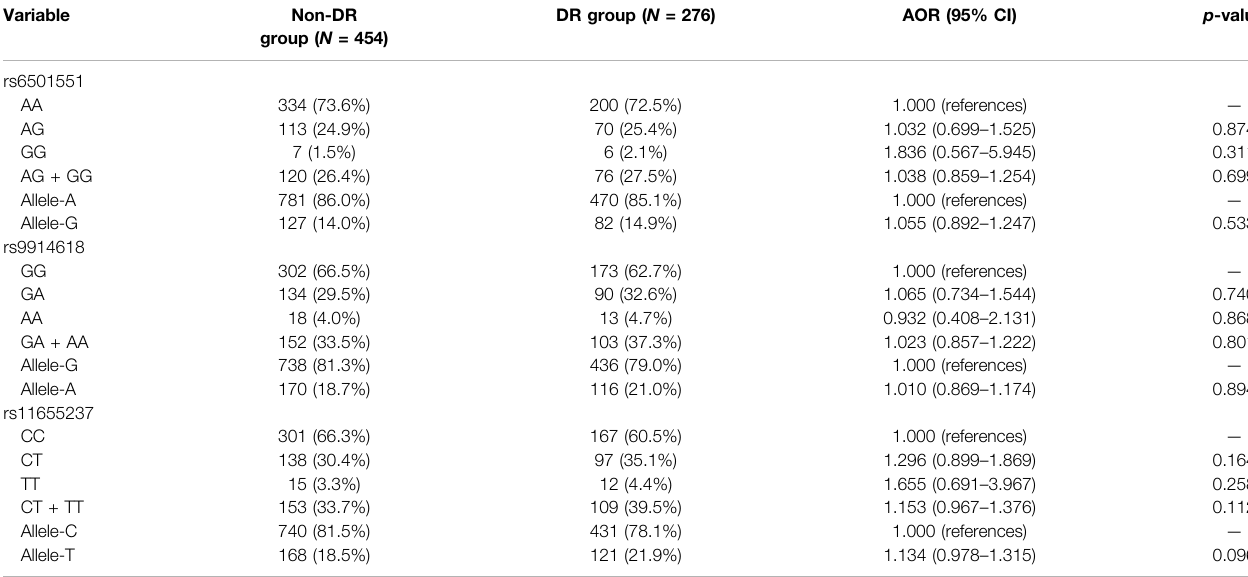
TABLE 2 | Adjusted odds ratio and 95% con fi dence intervals of diabetic retinopathy associated with LINC00673 genotypic frequencies.